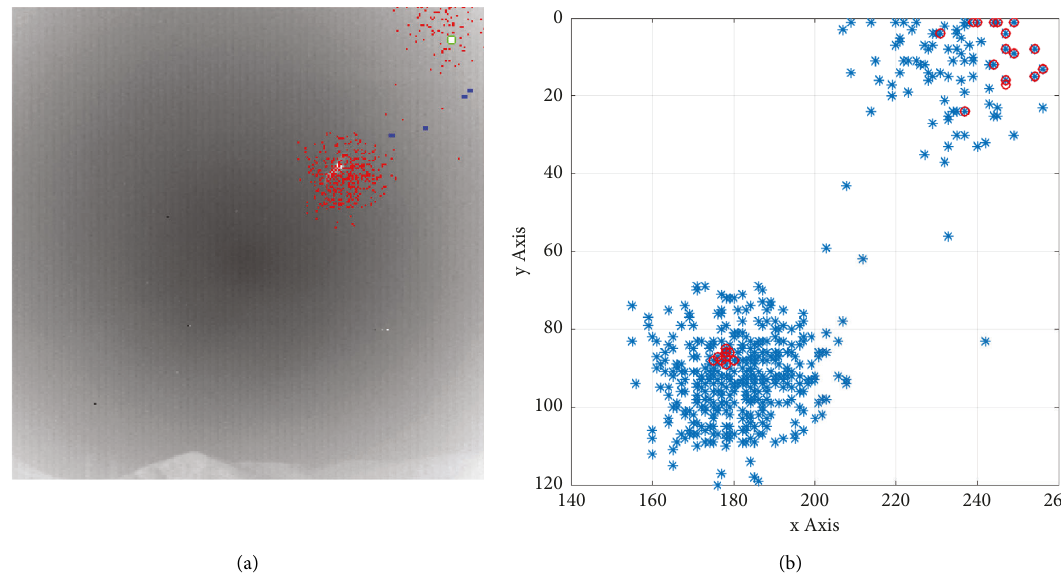
Figure 5: Fast-maneuvering dim-small target tracking. (a) Fast-maneuvering target detection. (b) Particle distributions before and after